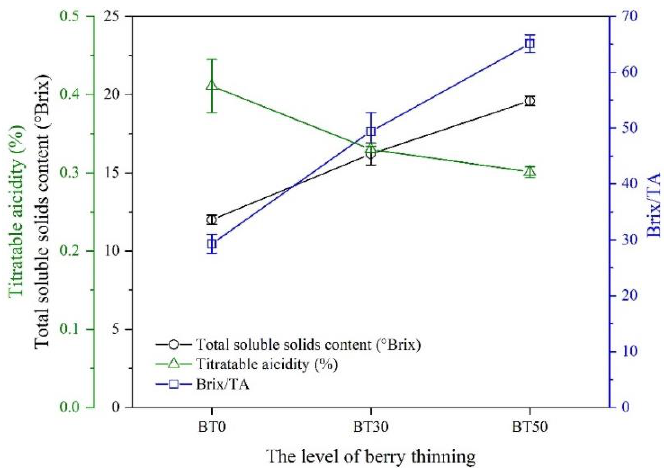
Figure 2. Effects of berry thinning on the total soluble solids content, titratable acidity, and Brix/TA of Shine Muscat grapes.